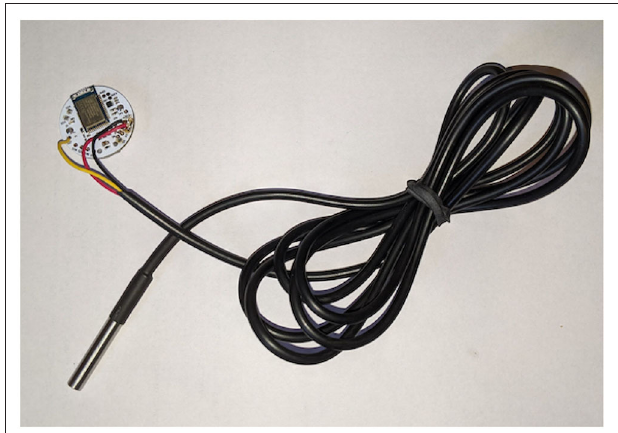
FIGURE 4 | The IoT monitor consisting of the Puck.js device with attached DS18B20 temperature probe.